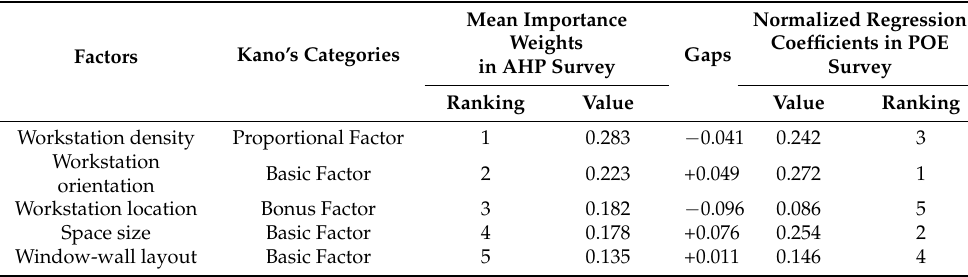
Table 8. Factor importance comparison between priori process and posteriori process.